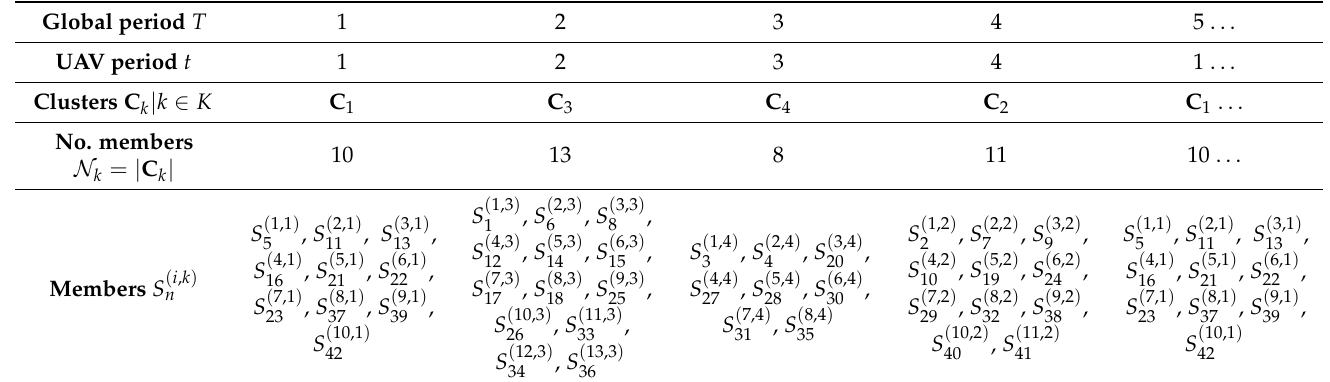
Table 5. Joint trajectory schedule for global transmission time period T and optimal number of clusters K , where the UAV period t = { ( mod { T , K }| mod { T , K } (cid:54) = 0 ) ∨ ( K | mod { T , K } = 0 ) } . 1 2 3 4 5 . . .